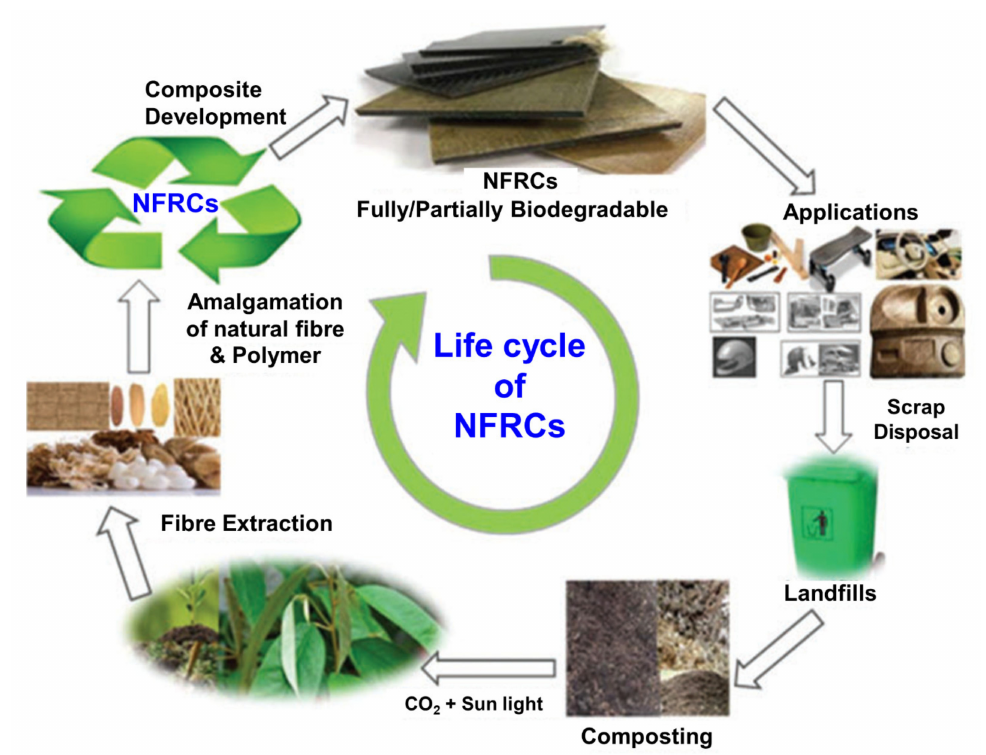
Figure 1. The life cycle of biodegradable, natural fibre reinforced composites (Reprinted with permission from [27]; Copyright 2018